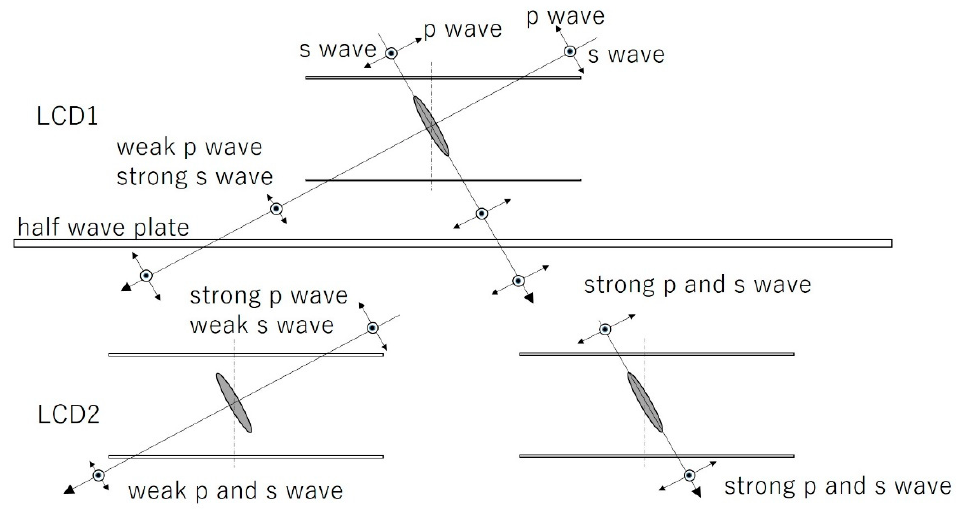
Figure 5. p-wave and s-wave through two-layer optically anisotropic LC filters in the direction of Θ and − θ .